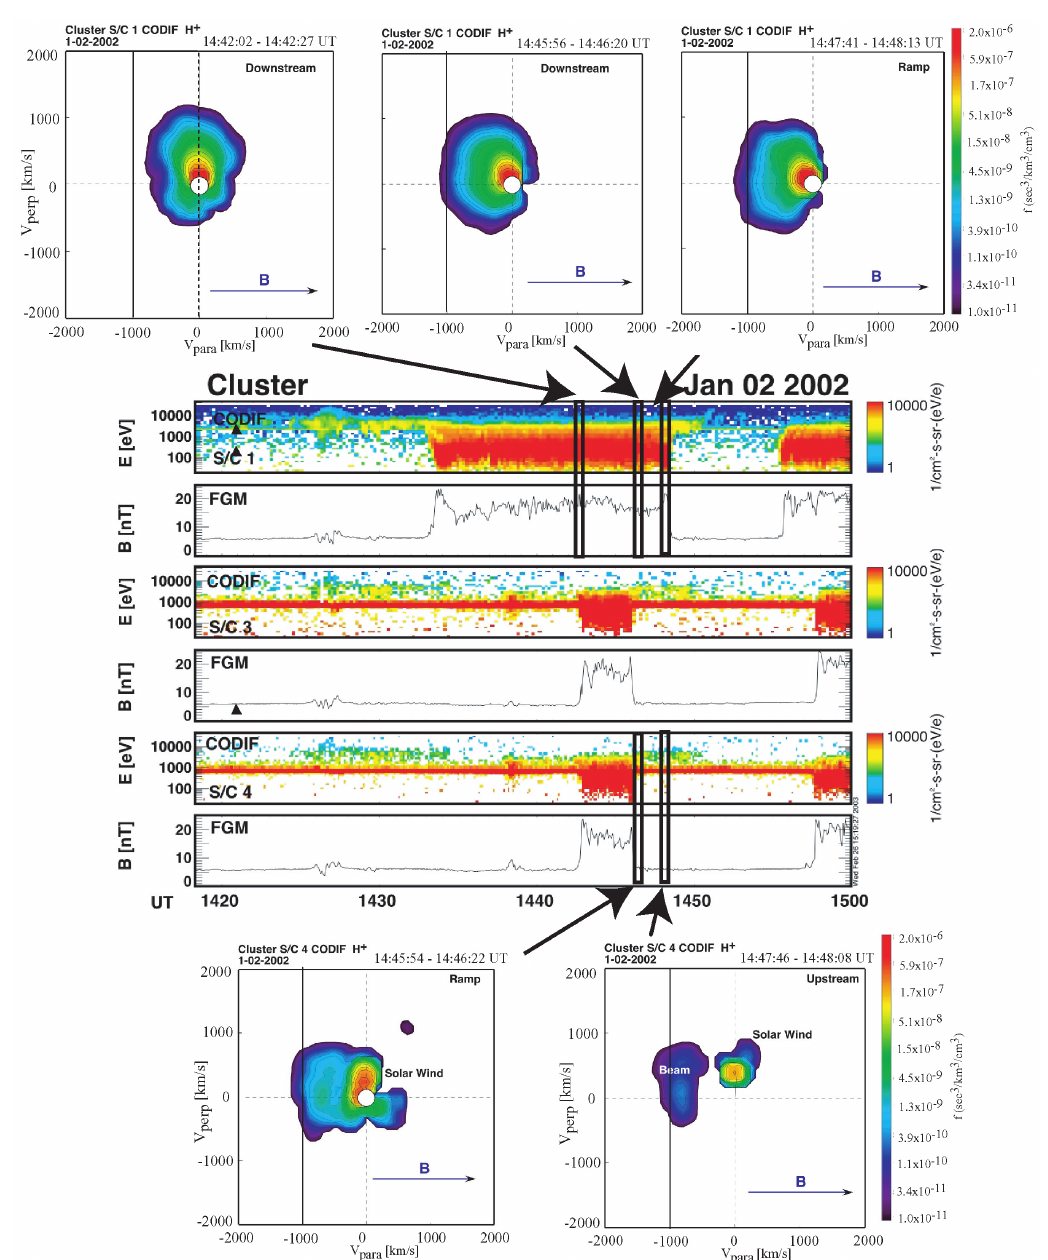
Fig. 6. Multi-spacecraft observations during crossing of the Earth’s bow shock on 2 January 2003. The top and lower panels show the color- coded velocity distribution in the V ⊥ -V k plane during a bow shock crossing. The middle part shows the differential flux and the magnetic field of the different